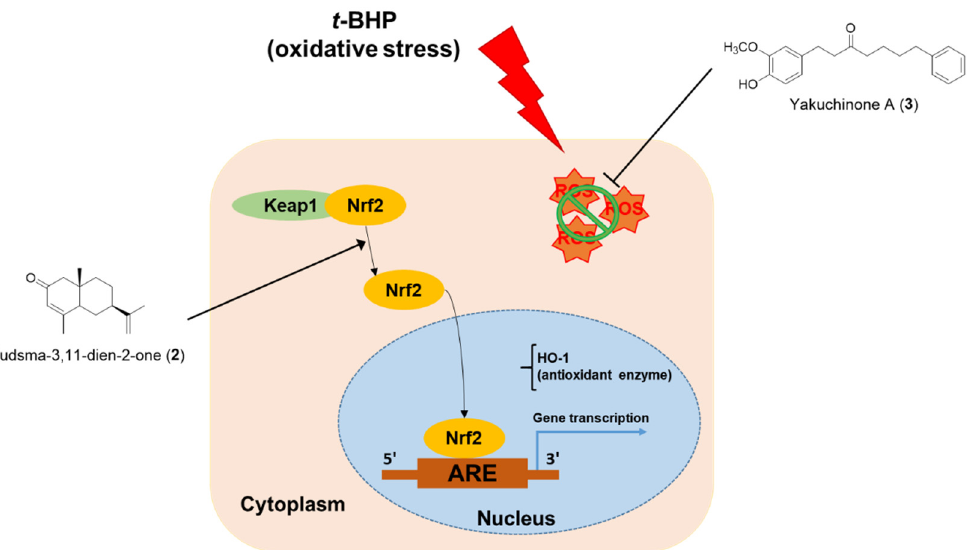
Figure 9. Proposed mechanism of active ingredients of A. oxyphylla for the protective activity against t -BHP-induced toxicity in HepG2 cells.